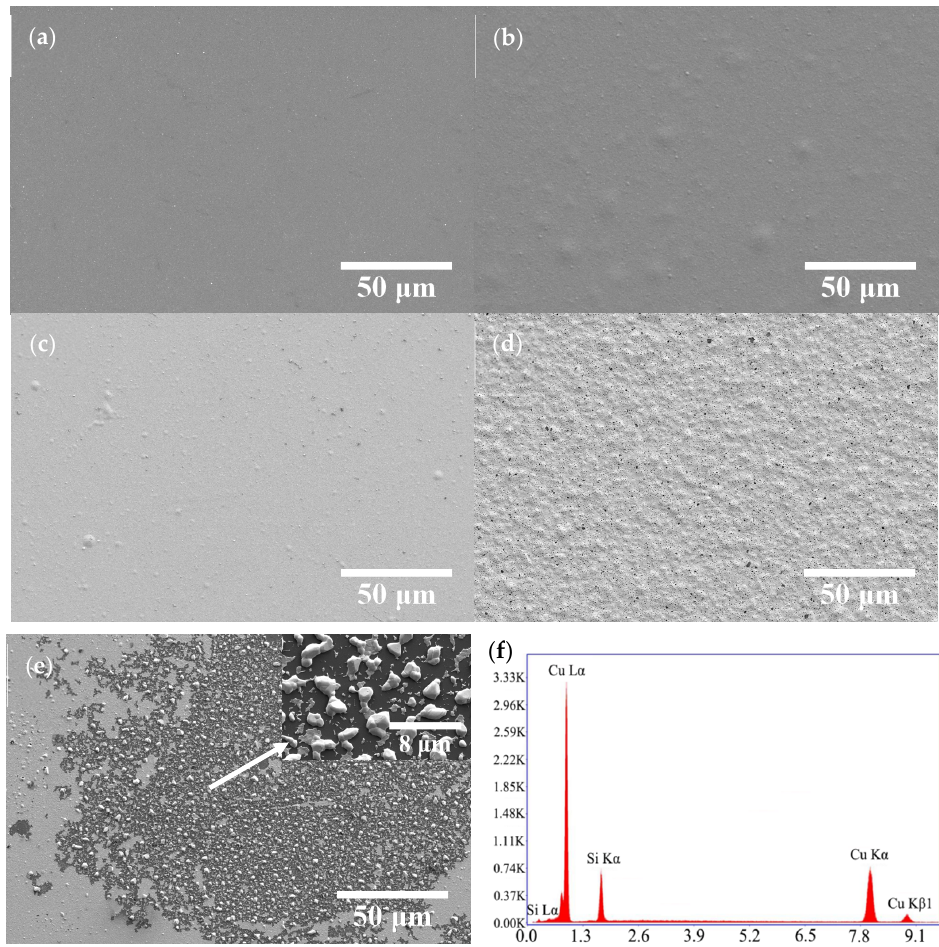
Figure 7. SEM images and EDS of Cu/COOH-APTMS/SiO 2 /Si samples after different annealing temperatures: ( a ) 350 °C; ( b ) 400 °C; ( c ) 450 °C; ( d ) 500 °C; ( e ) 550 °C; ( f ) EDS annealed at 550 °C.